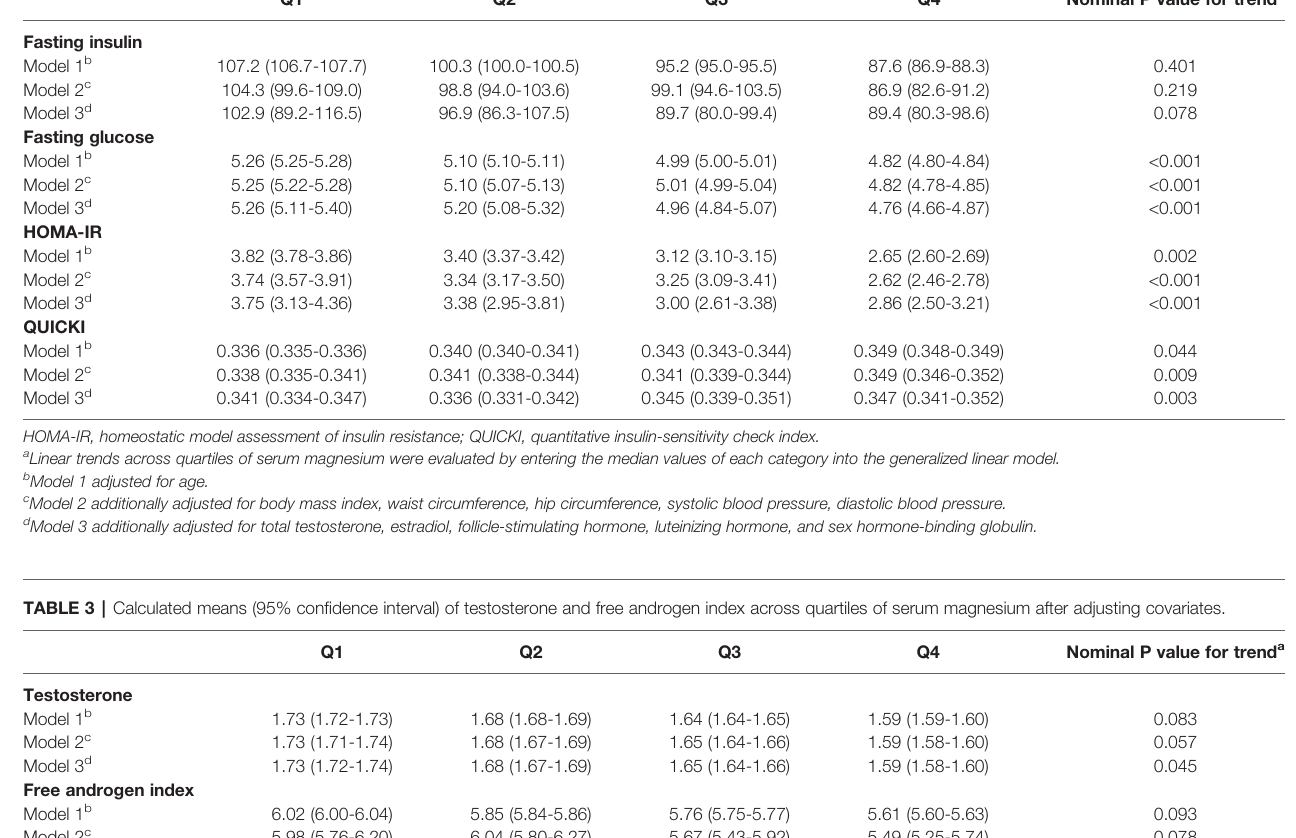
TABLE 2 | Calculated means (95% con fi dence interval) of insulin, glucose, HOMA-IR, QUICKI across quartiles of serum magnesium after adjusting covariates. Q1 Q2 Q3 Q4